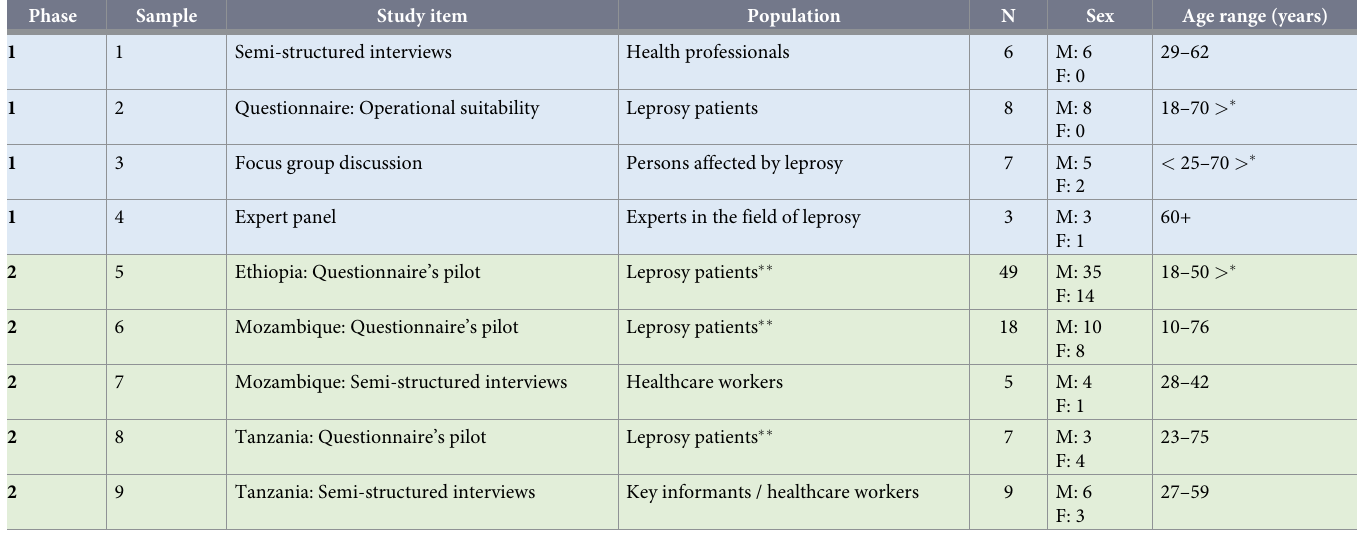
Table 2. Overview of general characteristics of the study population per study